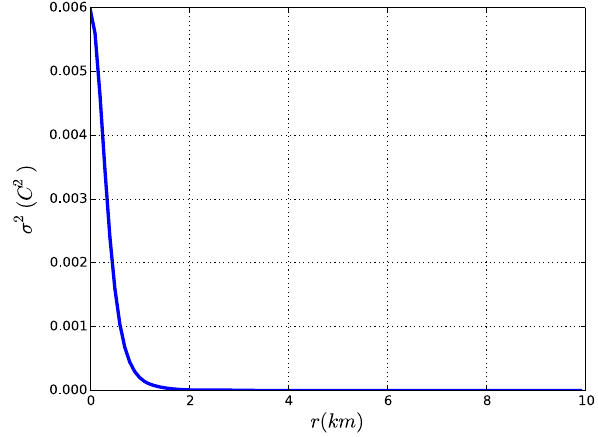
Fig. 6 Potential e 2 ν against radial distance